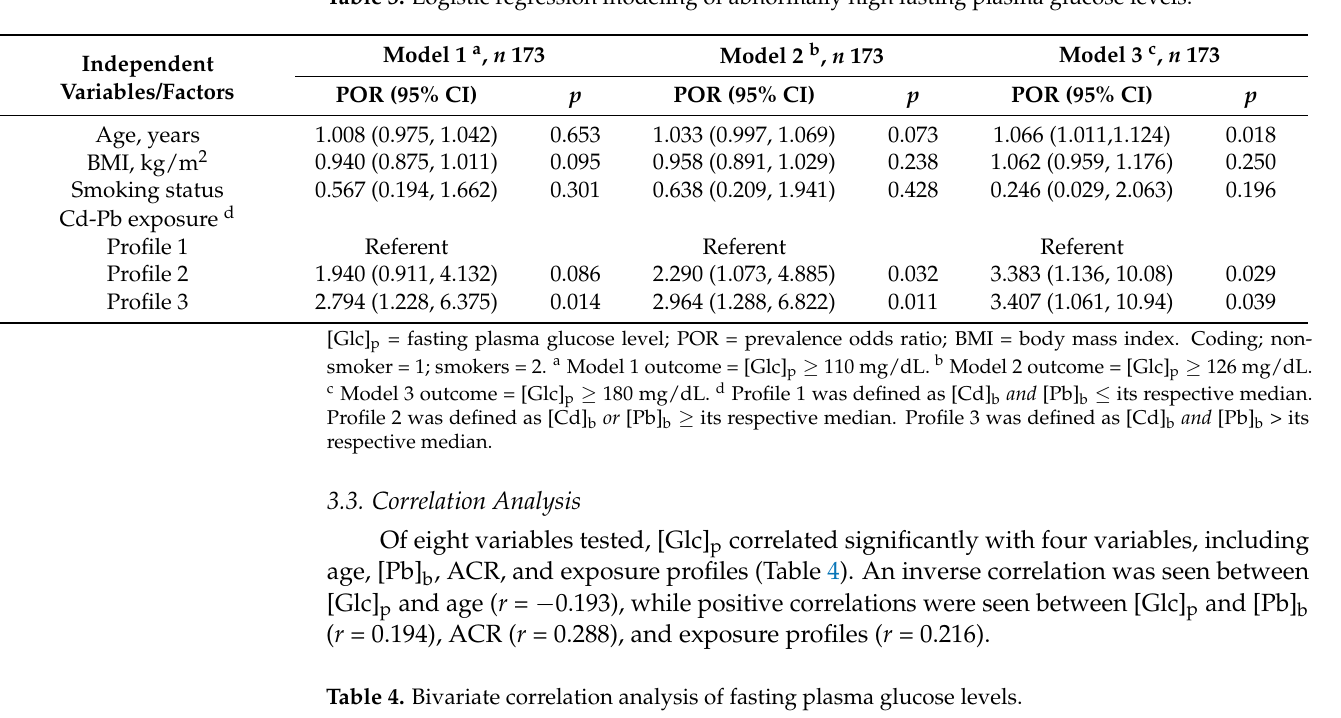
Table 3. Logistic regression modeling of abnormally high fasting plasma glucose levels.